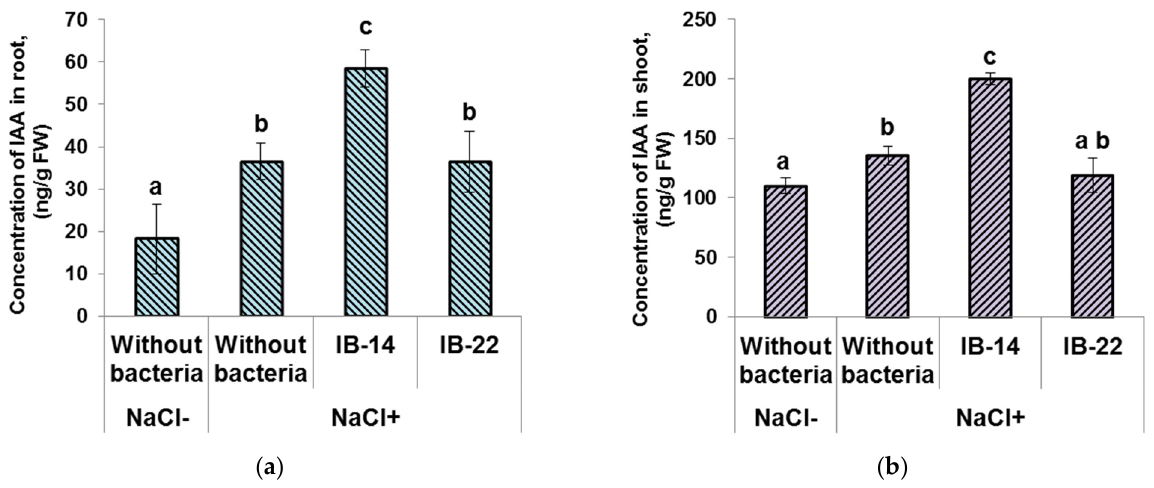
Figure 3. Effect of 100mM NaCl and bacterial treatment with Pseudomonas mandelii IB-Ki14 (IB-14) and Bacillus subtilis IB-22 (IB-22) on indole-3-acetic acid concentration in the roots ( a ) and in the shoots ( b ) of 6-day-old wheat plants. Data are means ± SE. Significantly different means are labeled with different letters at p ≤ 0.05, n = 6 (ANOVA followed by Duncan’s test).